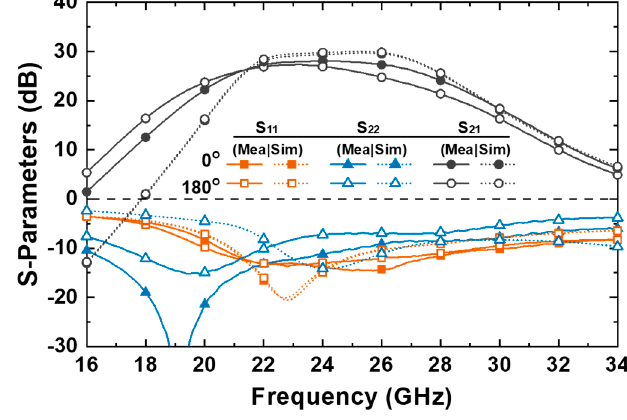
Figure 8. Simulation and measurement results: S-parameters.